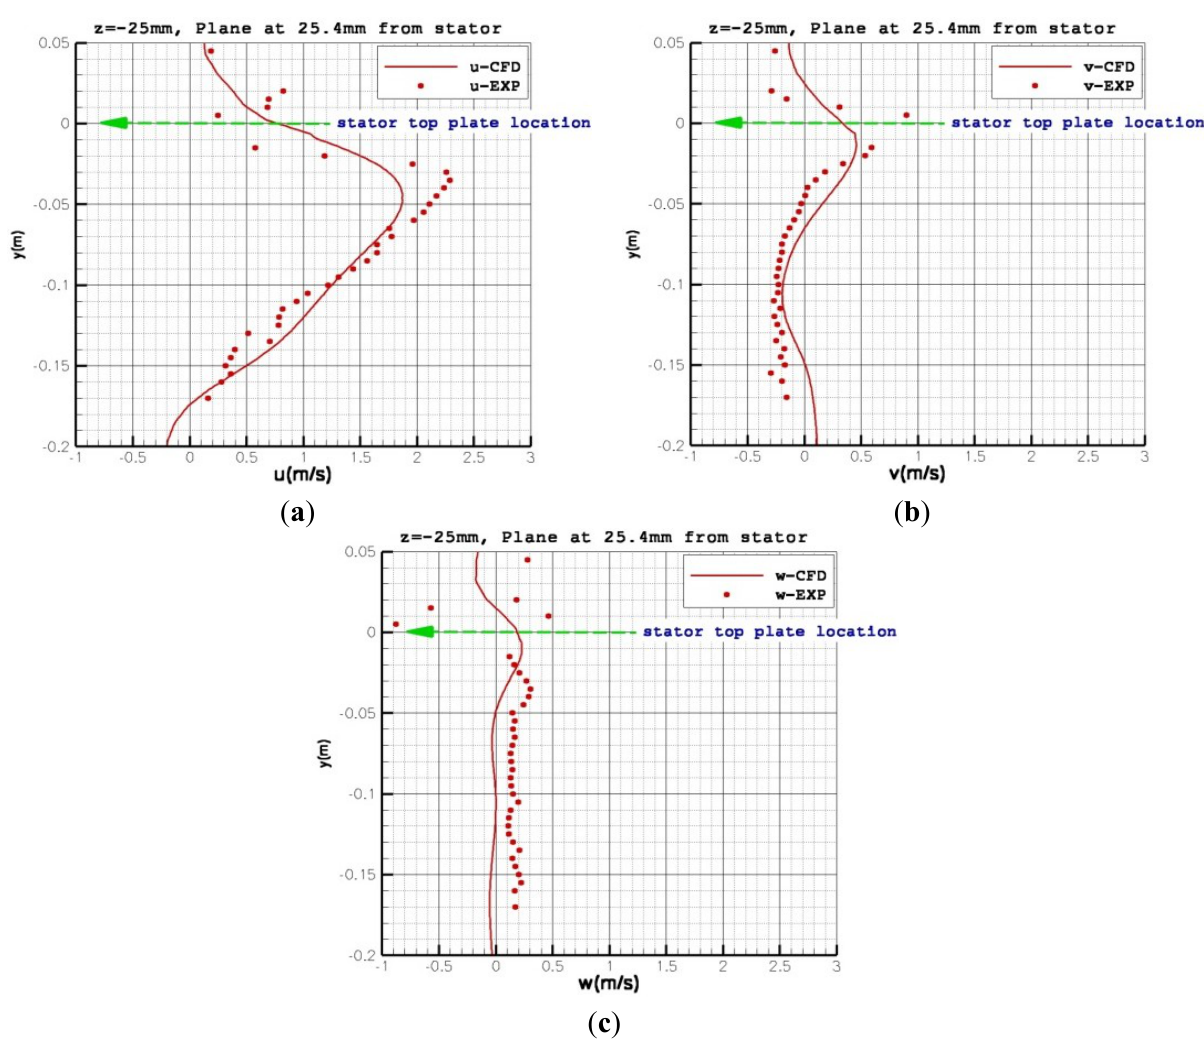
Figure A2. ( a ) Comparison of CFD results and experiments, radial velocity profile u ( y ); ( b ) comparison of CFD results and experiments, vertical velocity profile v ( y ); and ( c ) comparison of CFD results and experiments, tangential velocity profile w ( y